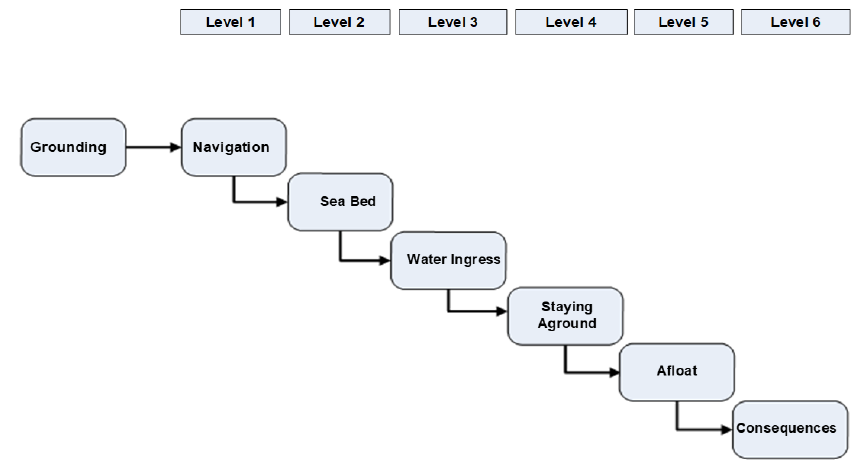
Figure 9. High-level event sequence for grounding risk model.